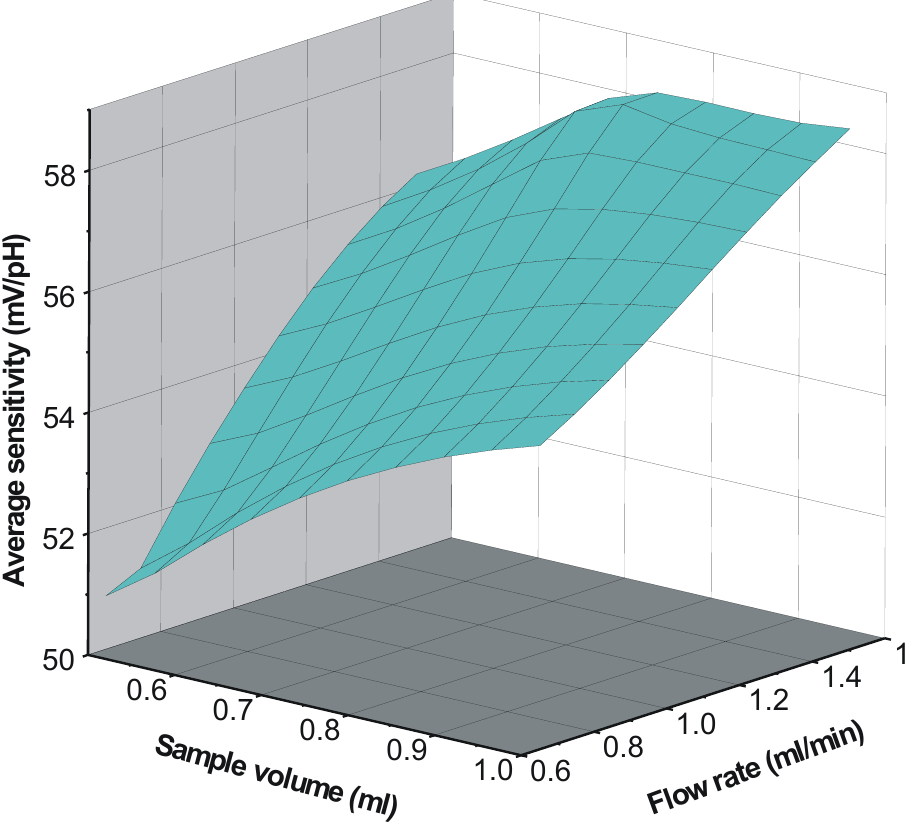
Figure 3. pH sensitivity of the EIS sensor in the FIA mode as a function of the injected sample volume and flow